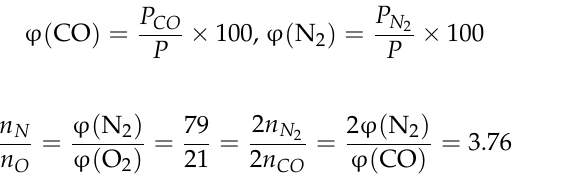
4 SiC 4 oxidized under different